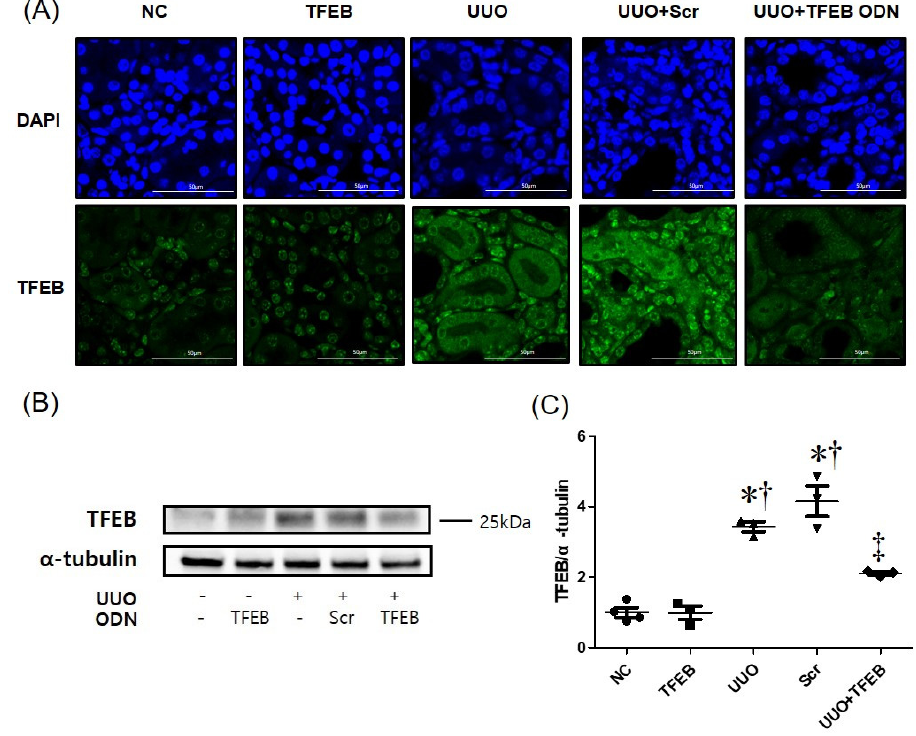
Figure 4. The effect of TFEB ODN on TFEB expression in UUO mice. ( A ) Immunofluorescence staining for TFEB (green). Cells were counterstained with Hoechst 33342 (blue). Original scale bar = 20 µ m. ( B ) Western blot analysis shows that TFEB decoy ODN decreased TFEB expression. (C) Quantitative analysis of TFEB expression in each group, performed at a magnification of 400 × . Data are presented as mean ± SEM ( n = 3). Tukey’s multiple comparison test, * p < 0.05 vs. the NC group. † p < 0.05 vs. the TFEB group. ‡ p < 0.05 vs. the UUO or Scr group. NC, normal control group; TFEB, TFEB decoy injection in the normal control group; UUO, UUO surgery group; Scr, scramble ODN injection in the UUO surgery group; UUO + TFEB, TFEB decoy ODN injection in the UUO surgery group; DAPI, 40, 6-diamidino-2-phenylindole; UUO, unilateral ureteral obstruction; decoy ODNs, decoy oligonucleotides; TFEB, Transcription factor EB; Scr, scrambled.